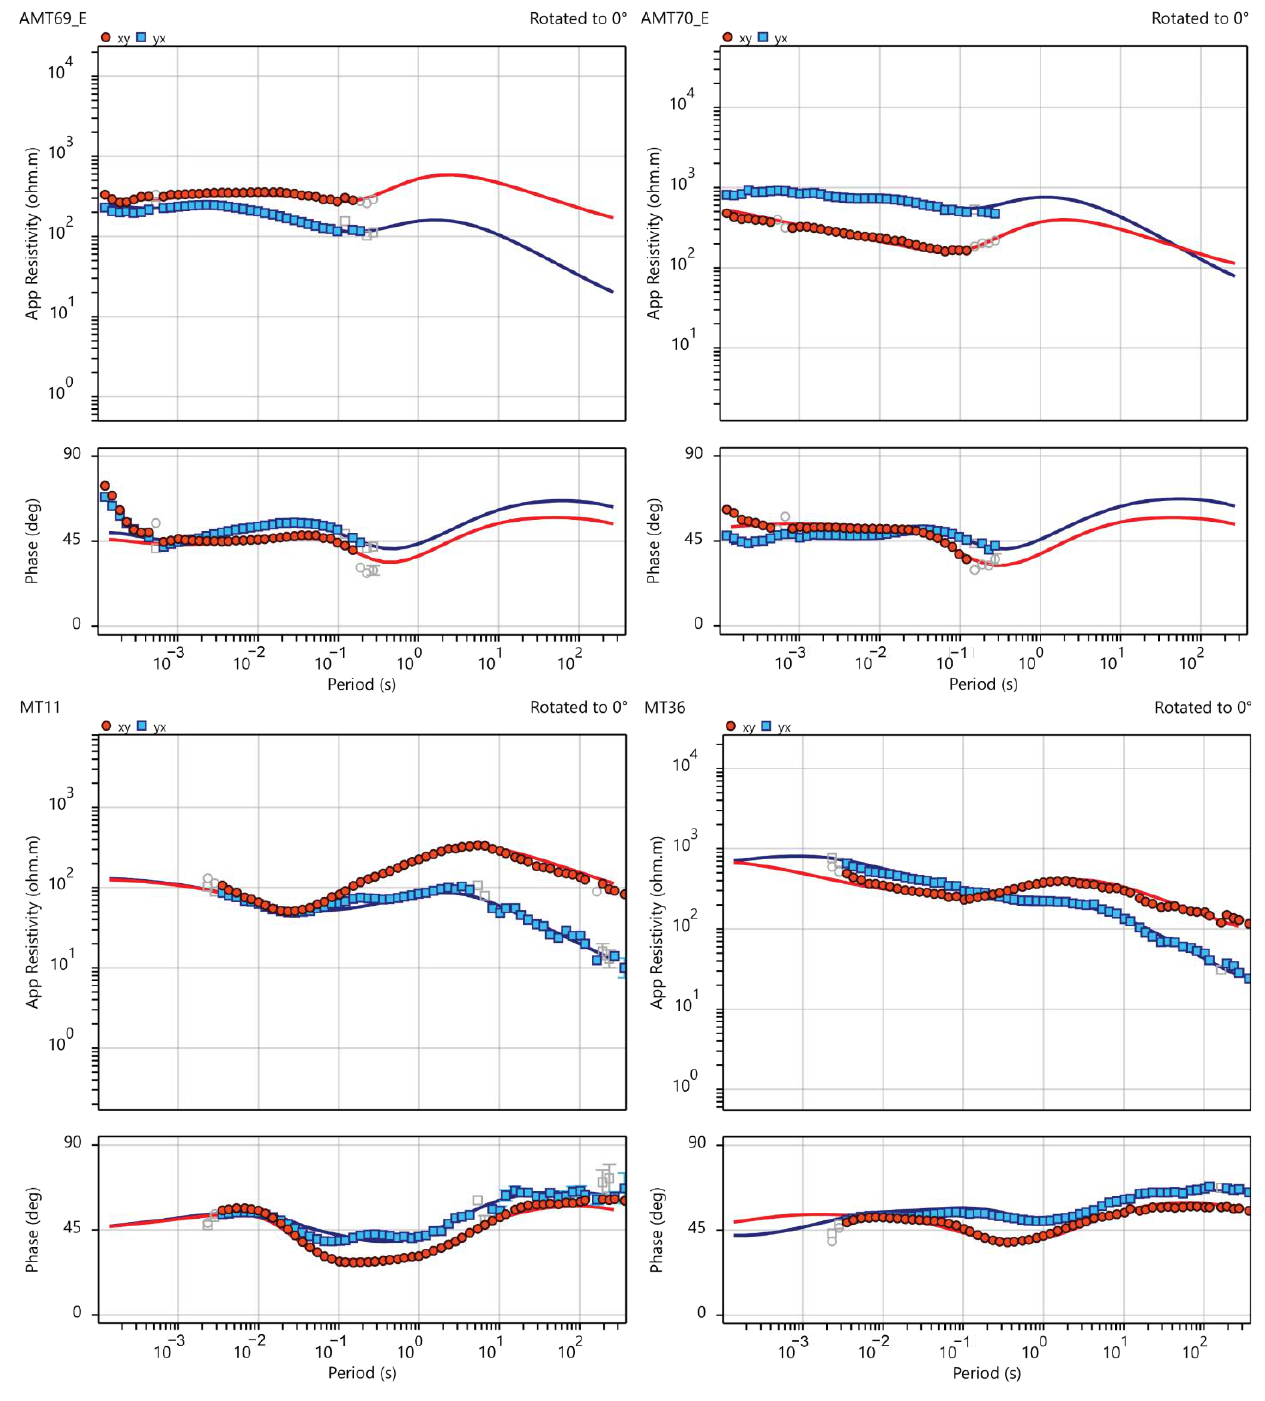
Figure 3. Measured (red circles (XY) and blue squares (YX)) and calculated (lines) apparent resistivity and phase curves for XY (red) and YX (blue) for four typical sites. Error bars plotted over the data as red or blue lines. Additional fits are found in Figure S4.